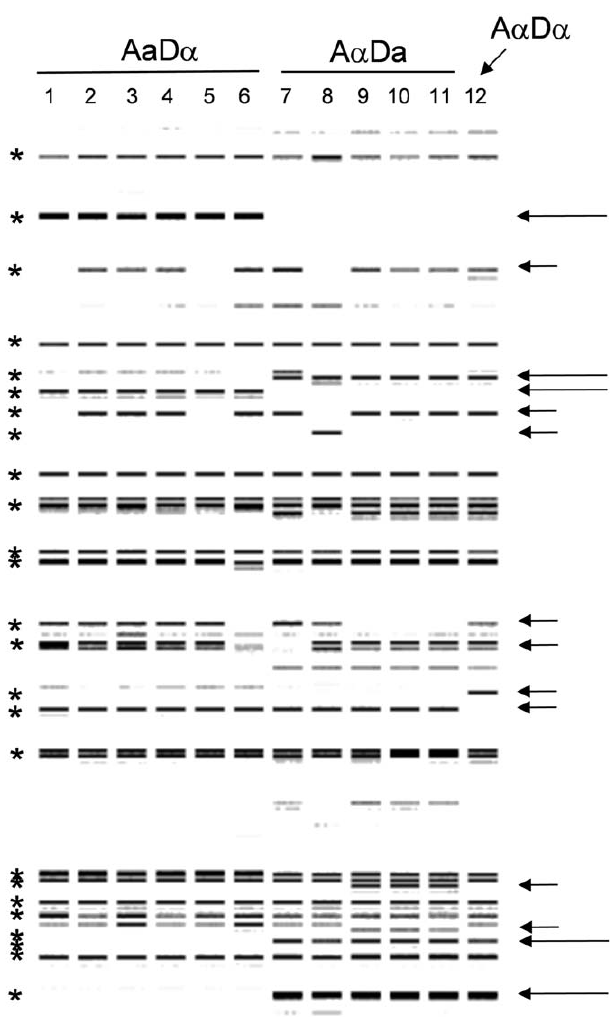
Figure 2. Computer-Generated AFLP Band Patterns of AD Hybrid Strains Lanes 1–6 represent A a D a strains CDC228, CDC304, it752, nc34–21, and MMRL1365, respectively. Lanes 7–12 represent A a D a strains ZG287, KW5, it744, it755, it756, and nc5–19, respectively. Lane 12 represents the unusual nc5–19 isolate that carries both serotype A and serotype D MAT a alleles (A a D a ). Bands that are polymorphic between A a and A a groups are indicated with long arrows, and bands that are polymorphic among the individual strains are denoted with short arrows. AFLP bands that were consistent between independent DNA preparations and analyses (see Materials and Methods) are labeled with the asterisks.